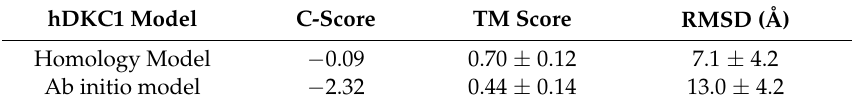
Figure 4. The hDKC1 models obtained by I-TASSER (Iterative Threading Assembly Refinement). ( A ) hDKC1 homology model; ( B ) hDKC1 ab initio model. Table 1. Quality evaluation scores of the predicted 3D structures by I-TASSER.